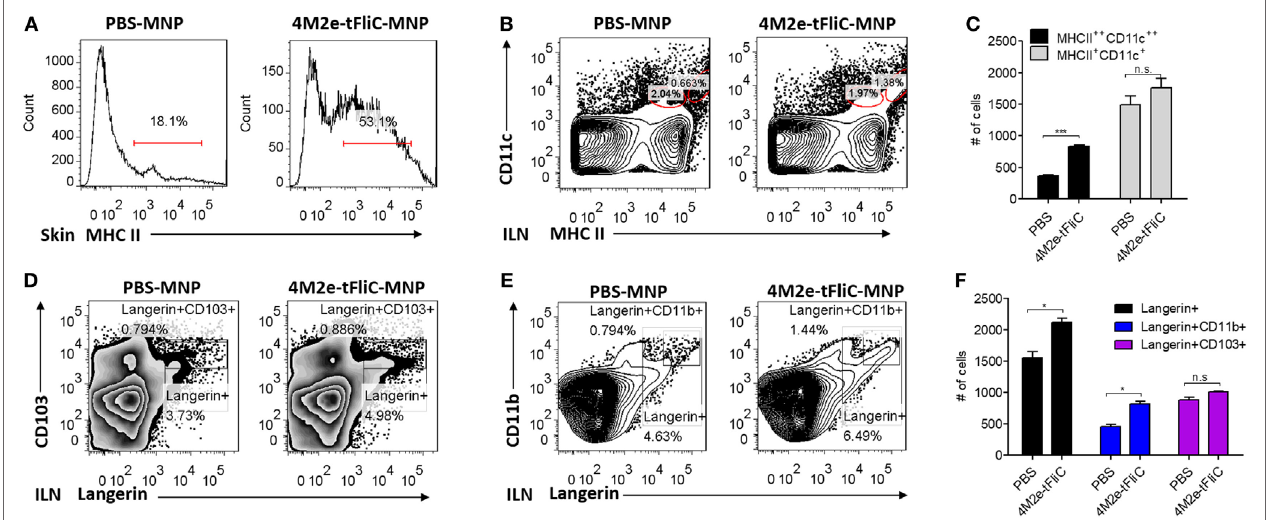
FigUre 7 | Microneedle patch (MNP) skin vaccination promoted antigen-presenting cell (APC) recruitment and dendritic cells (DCs) migration. (a) MHC II-positive cells were detected from mouse skin lymphocytes at day 7 post PBS treatment or 4M2e-tFliC MNP skin vaccination. The frequencies (B) and the numbers (c) of migratory DCs and subsets of migratory DCs (D–F) in inguinal lymph nodes were determined at day 7 post vaccination by FACS ( N = 4). Data represent mean ± SEM. The statistical significance was analyzed by Student’s t -test. * p < 0.05, ** p < 0.01, *** p < 0.001, n.s p >